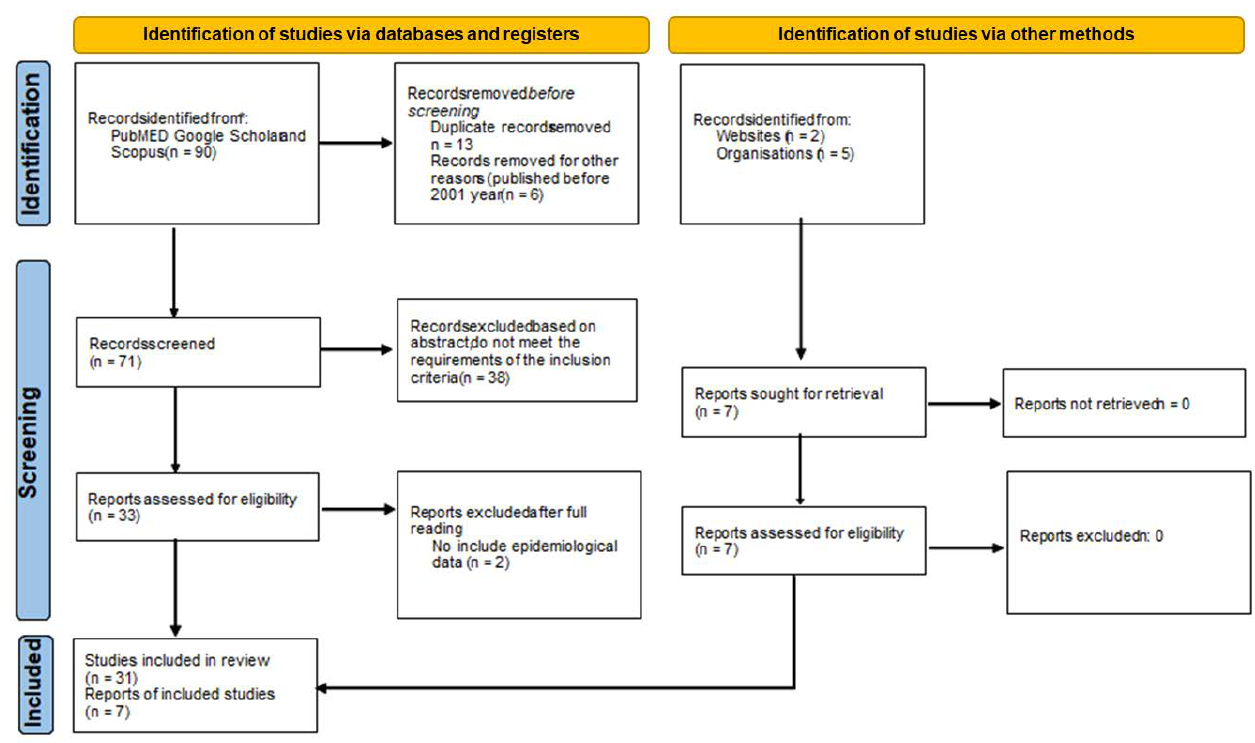
Figure 1. Flow diagram describing the search for publications on screening programs and results in